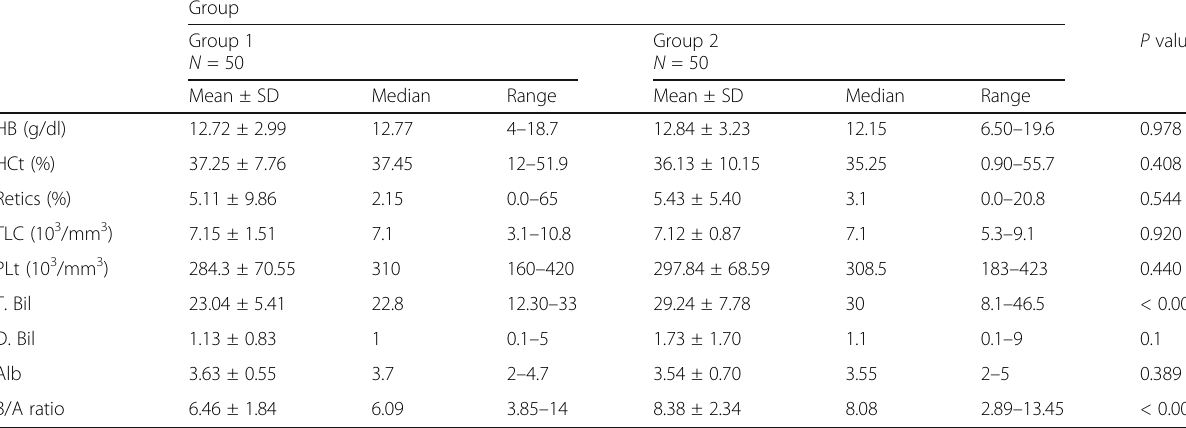
Table 9 Comparison between the two groups regarding laboratory investigations